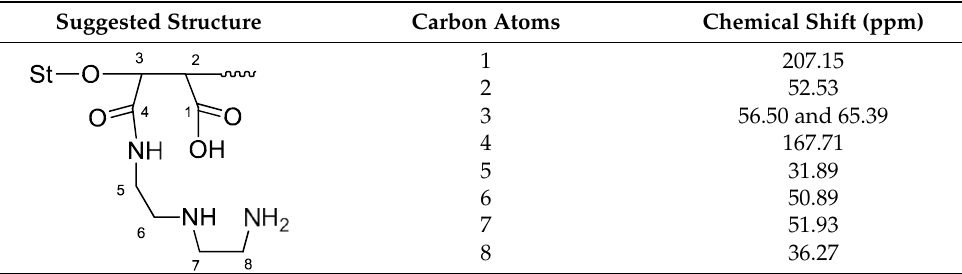
Table 3. 13 C-NMR chemical shifts of the St-g-(DETA-MA) copolymer.